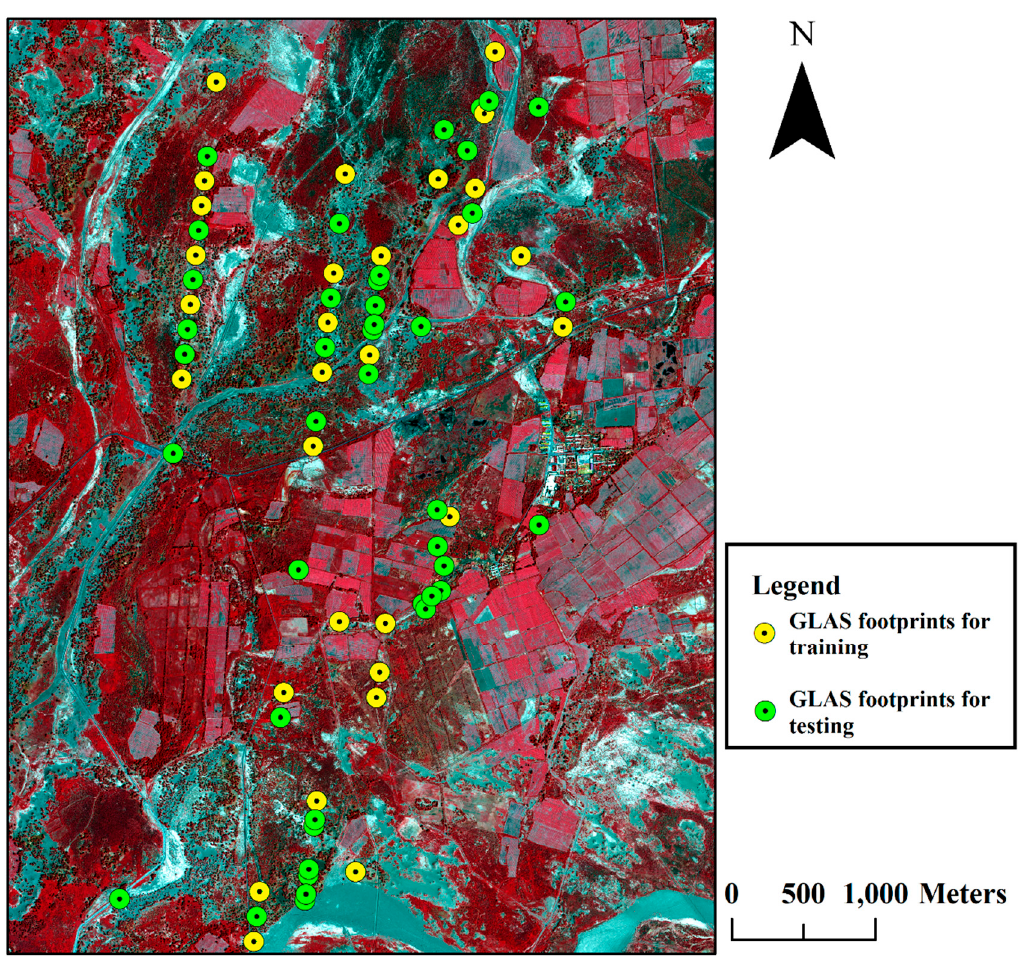
QuickBird imagery of the study area with 79 Geoscience Laser Altimeter System (GLAS) footprints.